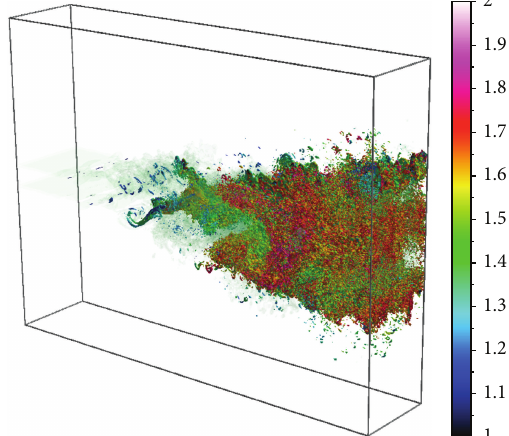
Figure 5: An instantaneous isosurface of vorticity colored by the geometric standard deviation, 𝜎 𝑔 .